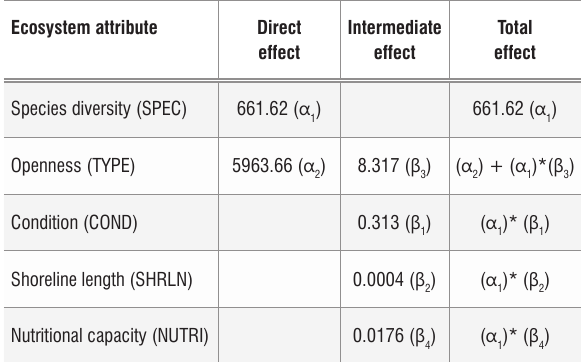
Table 4: Marginal impacts of estuary ecological structure on fish